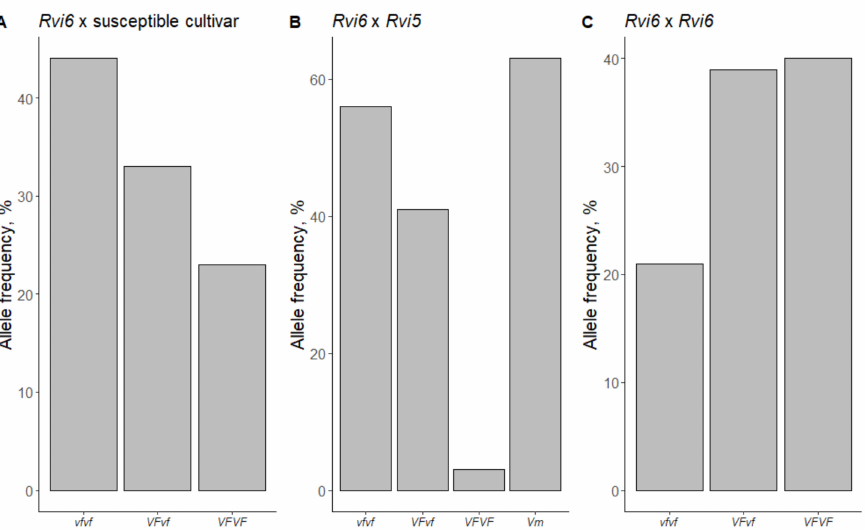
Figure 5. The frequency of identified alleles in Rvi6 and Rvi5 depending on the parent combination of resistance genes. Description of populations by apple scab resistance gene occurrence in parent plants: ( A )— Rvi6 × susceptible cultivar, ( B )— Rvi6 × Rvi5 , ( C )— Rvi6 × Rvi6